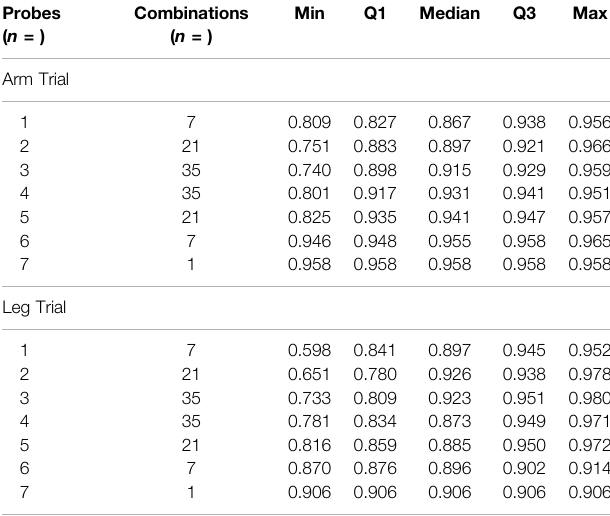
Data correspond to the fi ve-number summary of the distribution (i.e. minimum, Q1, median, Q3, maximum) of ICC values which have been presented graphicly in the box and whiskers plots shown in Figures 2 , 3